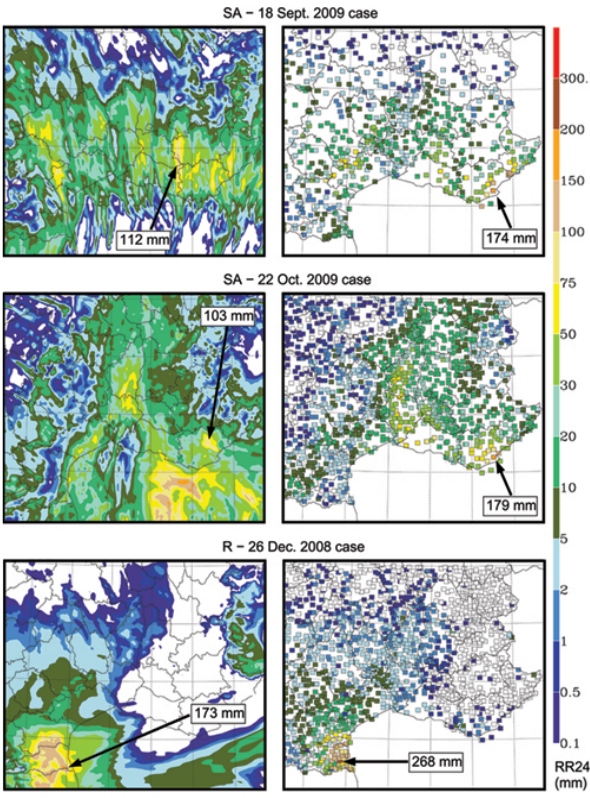
Fig. 5. Same as Fig. 3, but at 00:00UTC, 19 September 2009 for the 18 September 2009 case (top), at 06:00UTC, 23 October 2009 for the 22 October 2009 case (middle) and at 06:00UTC, 27 December 2008 for the 26 December 2008 case (bottom).